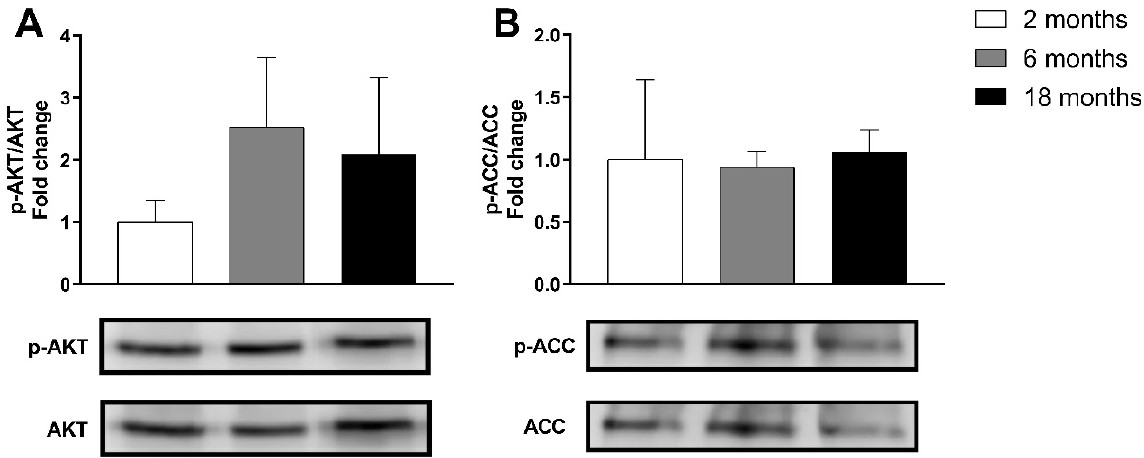
Figure 2. Representative Western blot and densitometry analysis of the effects of aging (2, 6 and 18 months) on phosphorylated AKT and total AKT ( A ) and phosphorylated ACC and total ACC ( B ) in the gastrocnemius muscle of C57BL/6J female mice fed a standard diet. Band densities of phosphorylated AKT and ACC were normalized by total AKT and ACC, respectively. Data presented as mean (SD); n = 3–4.